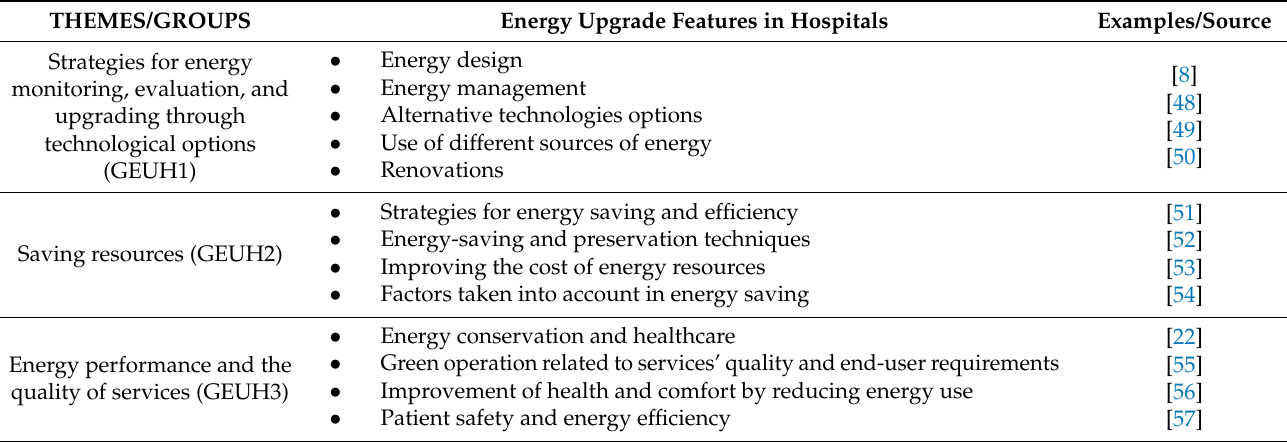
Table 1. Classification and characteristics of the energy upgrade features of